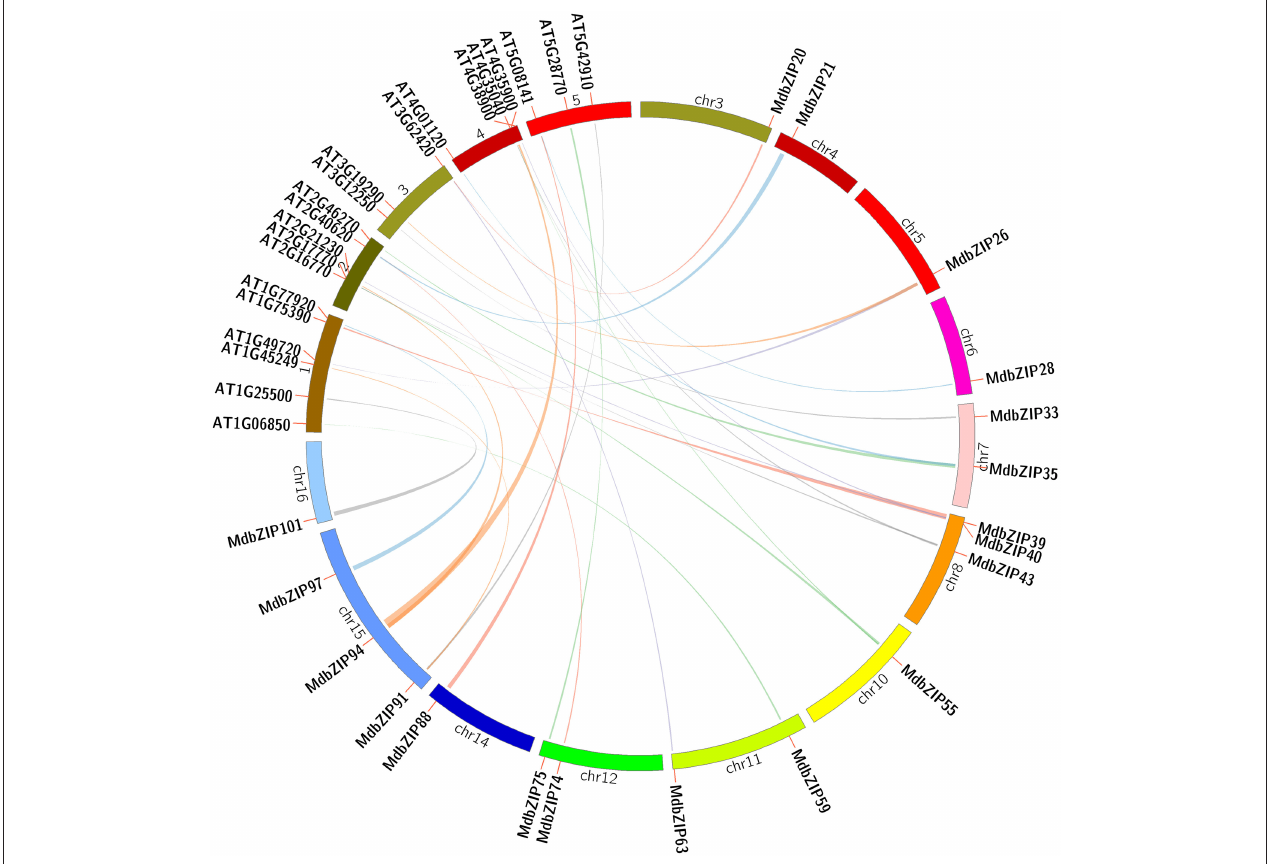
FIGURE 4 | Synteny analysis of bZIP genes between apple and Arabidopsis thaliana . Apple and A. thaliana bZIP genes are indicated by vertical orange lines. Colored lines connecting two chromosomal regions indicate syntenic regions between apple and A. thaliana chromosomes.